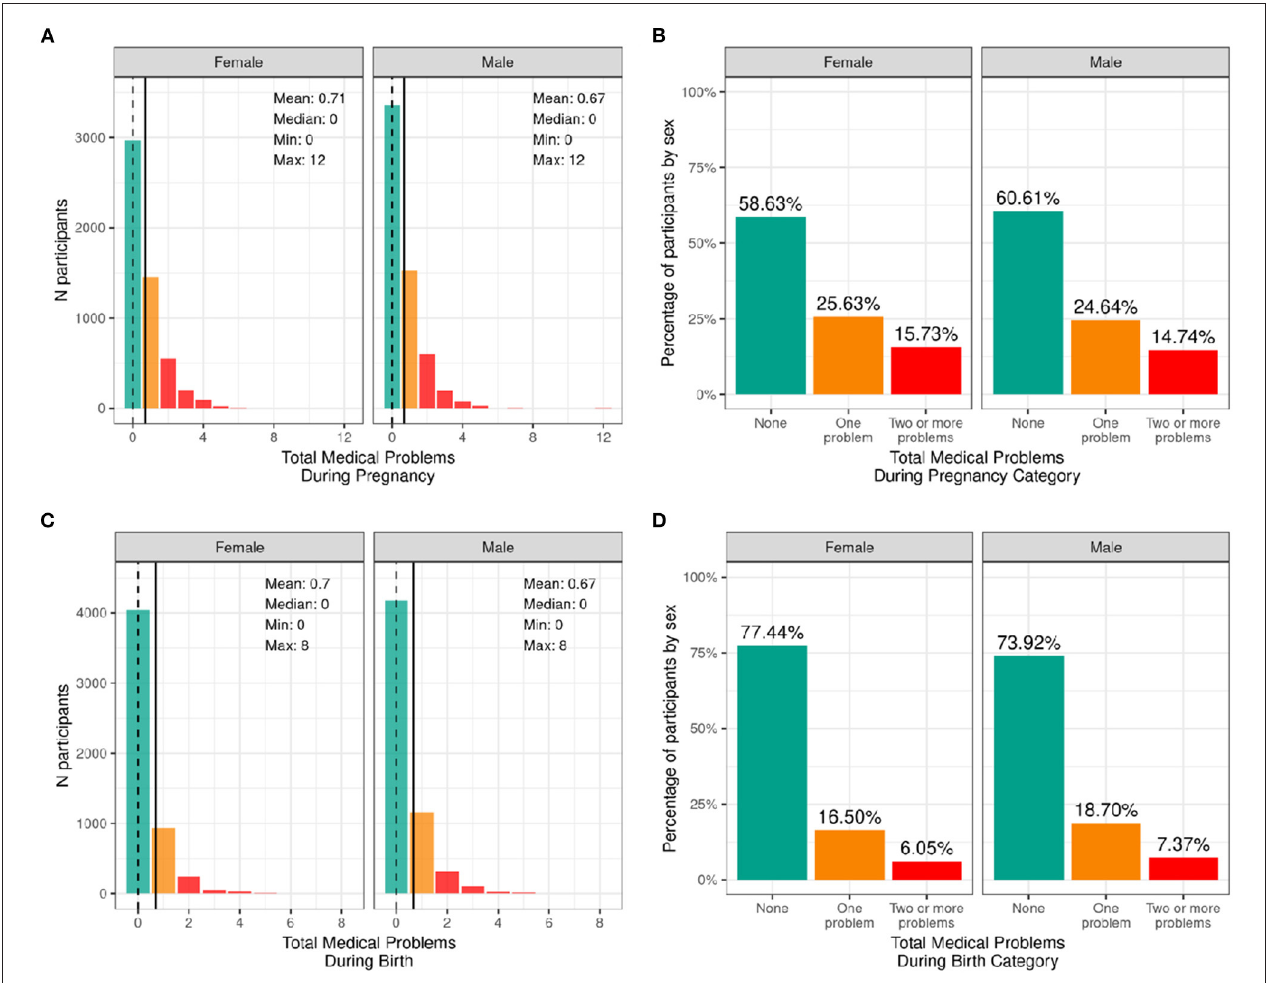
FIGURE 4 | Distribution of participants who experienced medical problems during birth and pregnancy. Continuous distributions of the total number of medical problems experienced by each participant during pregnancy (A) and during birth (C) stratified by sex assigned at birth and color coded by the number of problems experienced: none (green); one problem (orange); two or more problems (red). Percentage of participants (stratified by sex assigned at birth) who fell into these categories for problems experienced during pregnancy (B) and during birth (D)